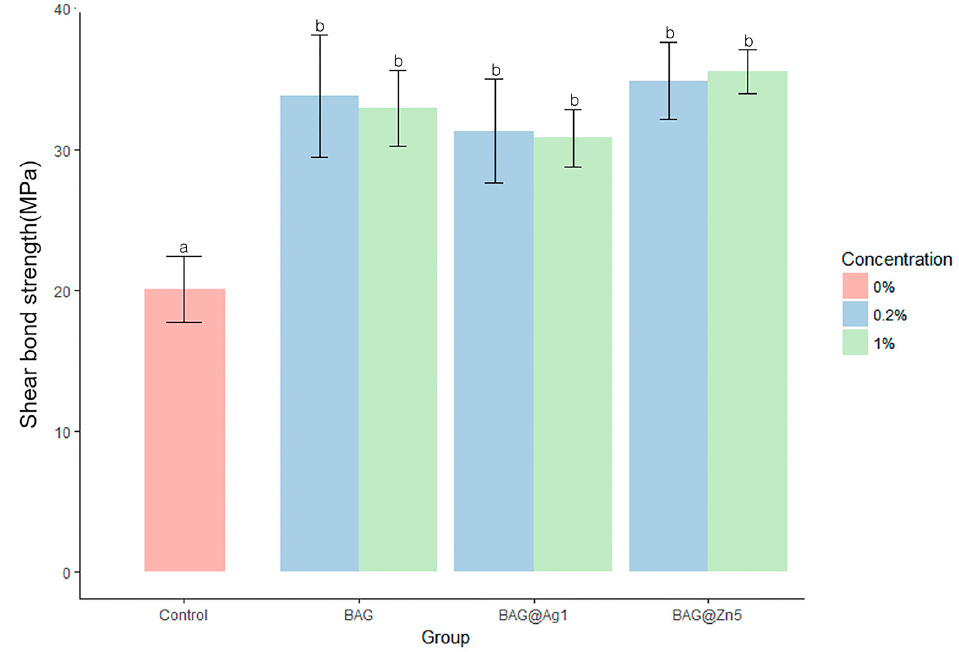
Figure 3. Comparison of the shear bond strength of the BAG and ion-doped BAG orthodontic bonding primer. Error bars indicate the ± standard deviation. The same letters indicate that the p -value is not significantly different ( p < 0.05). p < 0.05 using Duncan’s Multiple Range Test ( n = 5).